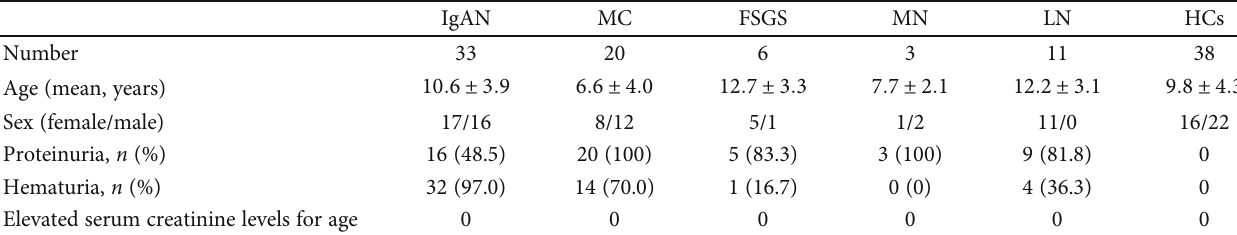
Table 1: Clinical characteristics of children with various